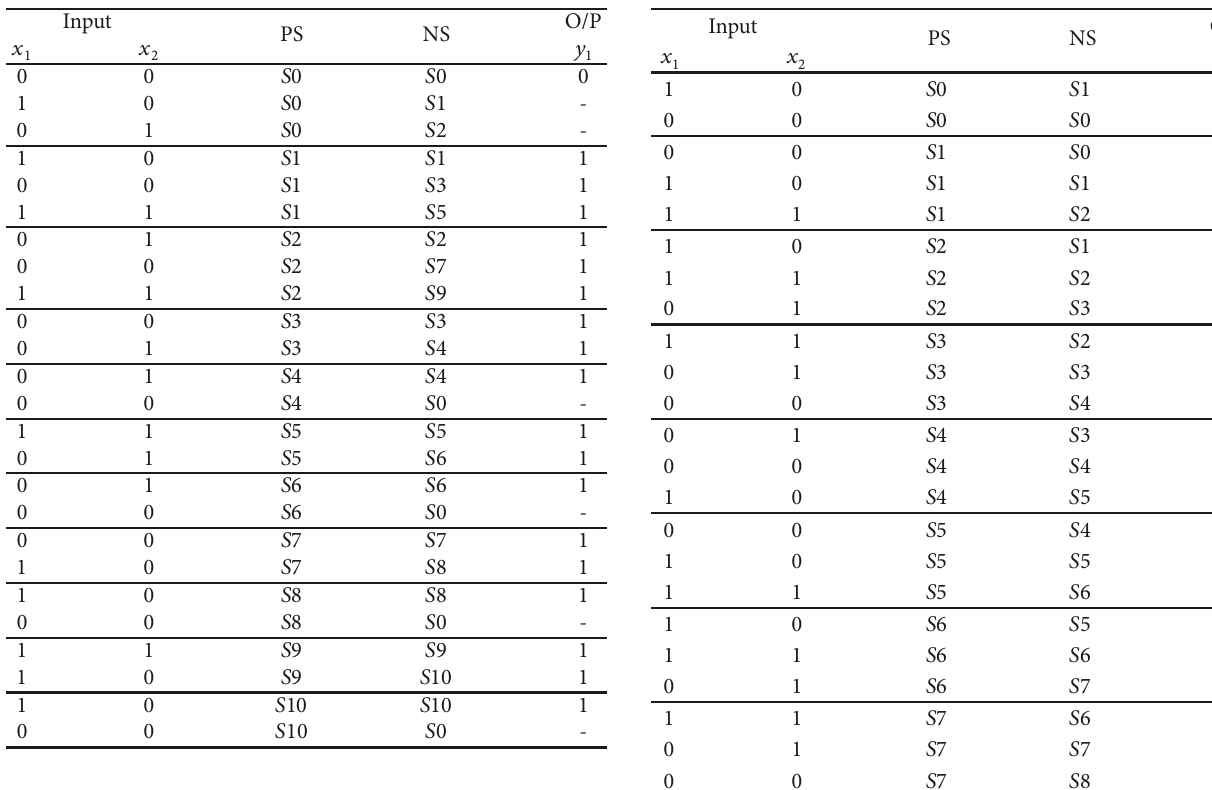
Table 1: Description of 𝑡𝑟𝑎𝑖𝑛11 from MCNCFSMBenchmarks[14]. Table 2: Description of 𝑙𝑖𝑜𝑛9 from MCNC FSM Benchmarks